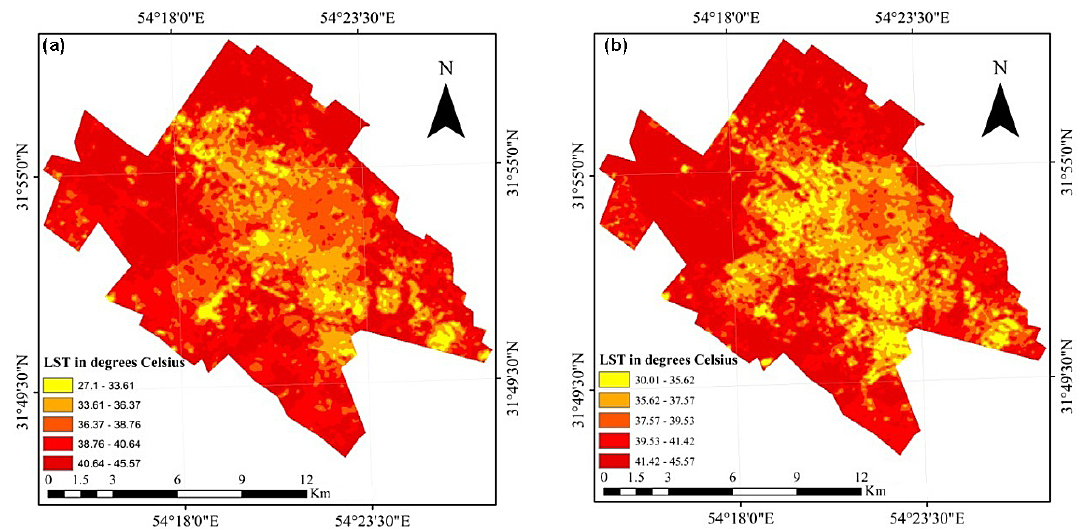
Figure 8. Land surface temperature retrieved from Landsat TM TIRS data at urban area of Yazd city: (a) 8 August 1998, (b) 6 August